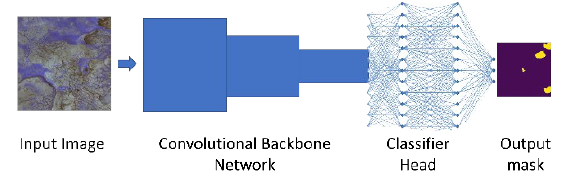
Figure 3 . Selected study areas from Banks Island (left) and Ellesmere Island (right) in Canada. Figure 2 . Simplified schematic diagram of transfer learning in convolutional neural networks. (Imagery © 2016 DigitalGlobe, Inc).